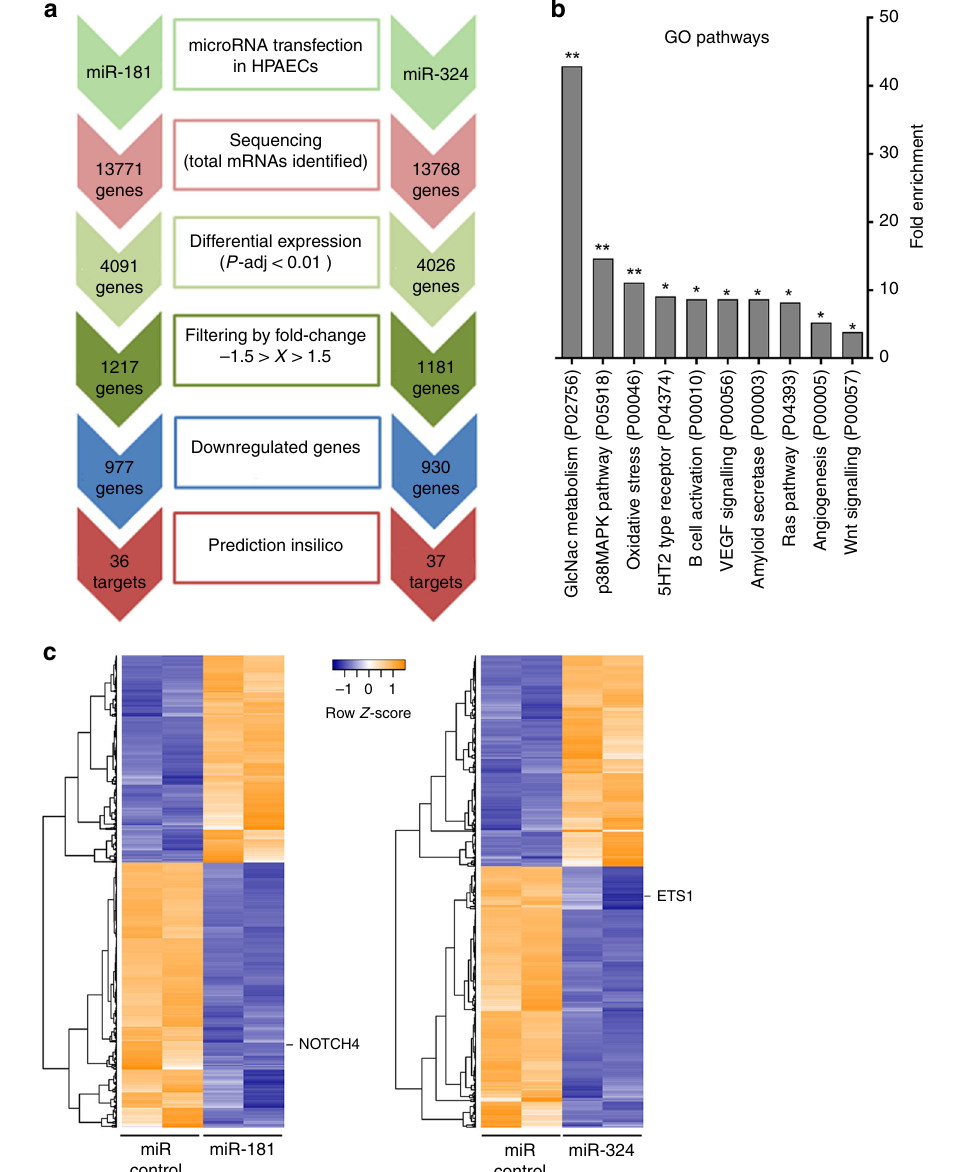
Fig. 5 Identi fi cation of miR-181 and miR-324 targets using RNA sequencing and pathway analysis. a Flow chart shows identi fi cation of potential miRNA targets in PAH. HPAECs were transfected with miRNA mimics and subjected to RNA sequencing. Pairwise differential expression analysis was performed based on a model using the negative binomial distribution and P values were adjusted for multiple test correction using the Benjamini – Hochberg procedure; * P < 0.05, ** P < 0.01. miRNA target prediction was carried out with TargetScan Human, miRecords and Ingenuity Expert Findings (IPA). b Gene enrichment (GO pathways, Panther) in HPAECs transfected with miR-181 and miR-324. c Heat map and unsupervised hierarchical clustering. The clustering was performed on two control samples (HPAECs transfected with miRNA control) and two samples of HPAECs transfected either with miR-181 or miR-324. Yellow colour represents an expression level above mean and purple colour represents expression lower than the